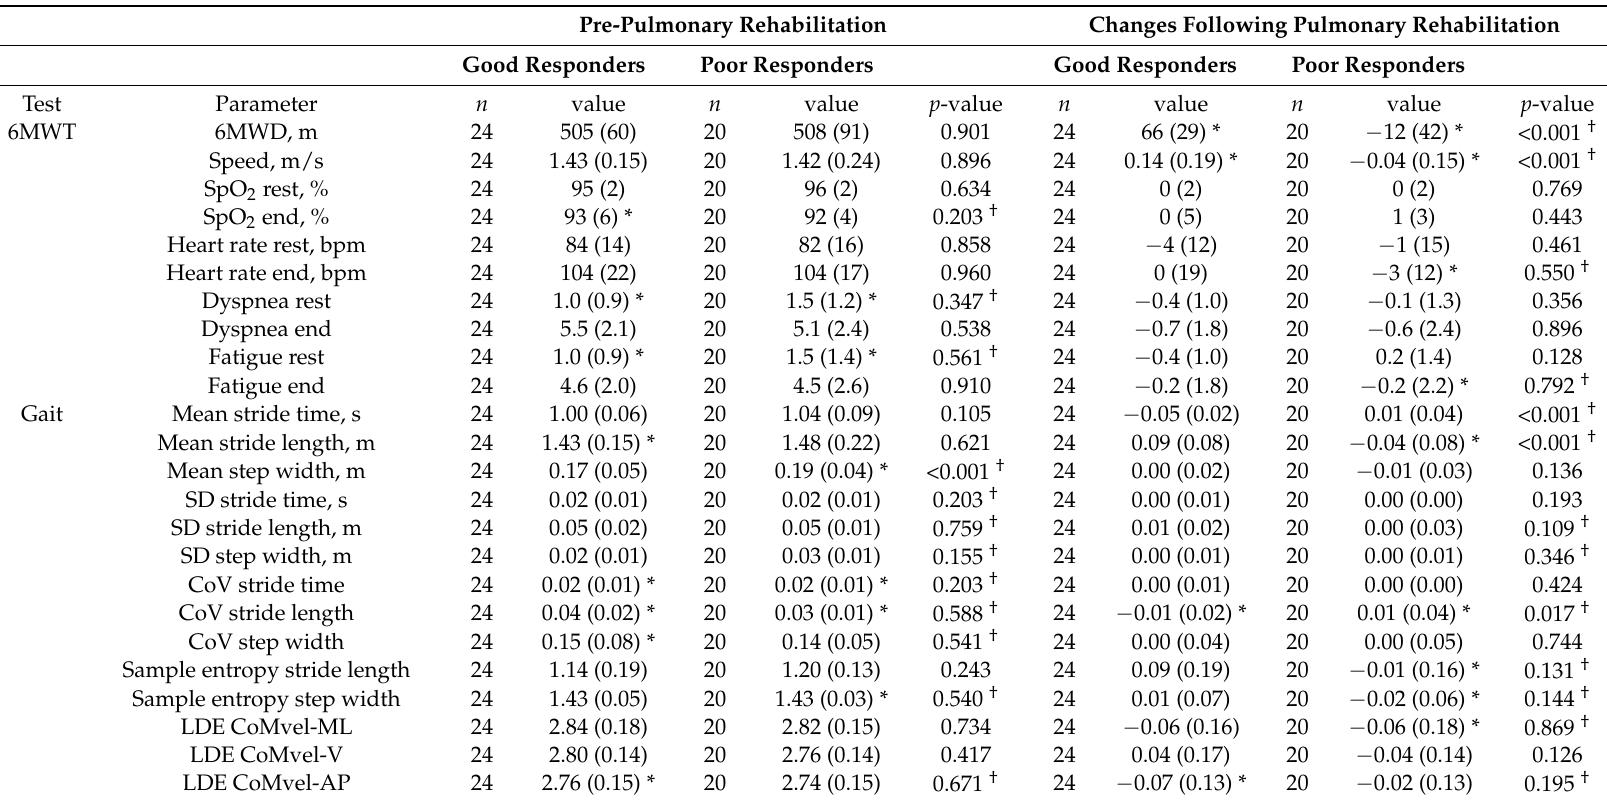
Table 5. The 6MWT outcomes and gait parameters in good and poor responders during the GRAIL-based 6MWT before and after pulmonary rehabilitation. Pre-Pulmonary